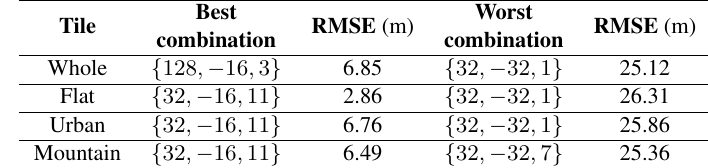
Table 2: Best and worst combinations with respective RMSE values for all tiles